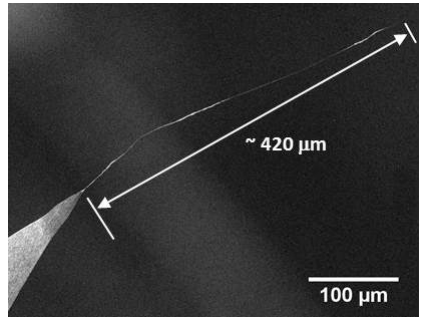
Figure 4. SEM image of a long CNT fibre, drawn by the solvent evaporation method.